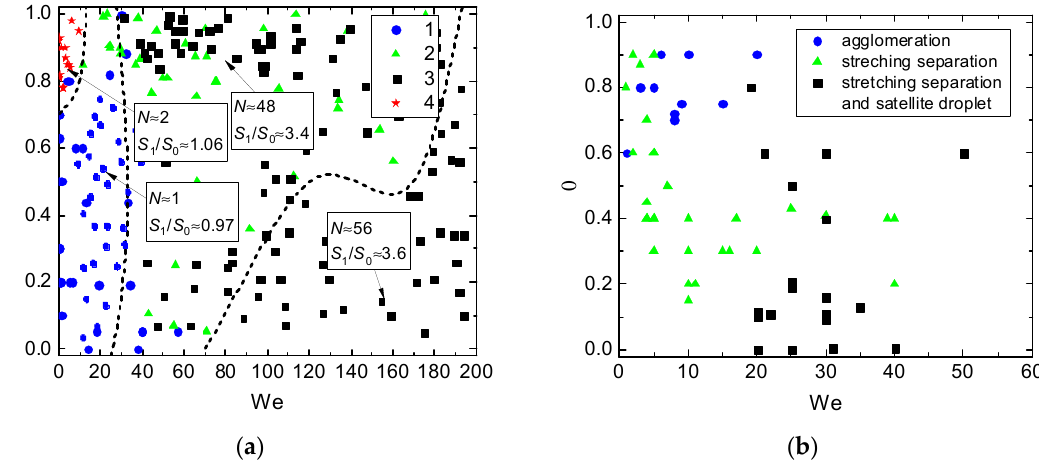
Figure 9. Interaction regime maps considering dimensionless angular parameter ( a ) for water slurry under study: 1—coalescence, 2—separation, 3—disruption, 4—bounce; ( b ) data for water [45].